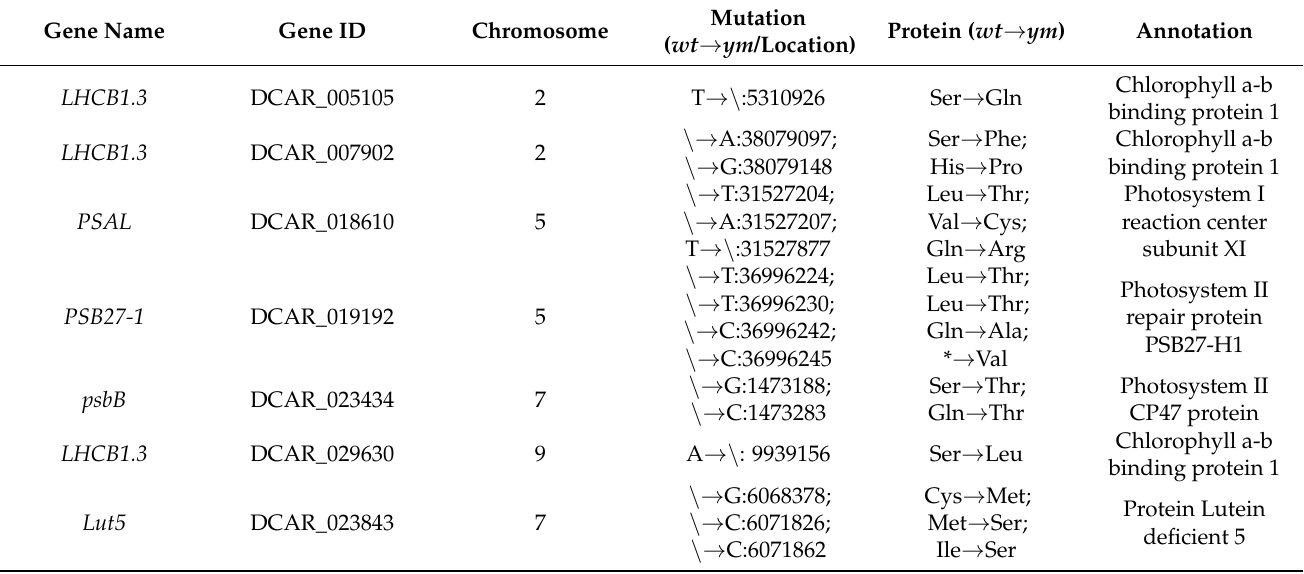
Table 2. Variation information of candidate